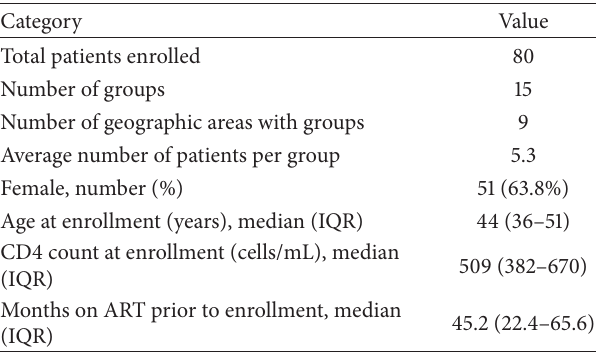
Table 1: Baseline characteristics of Group of 6